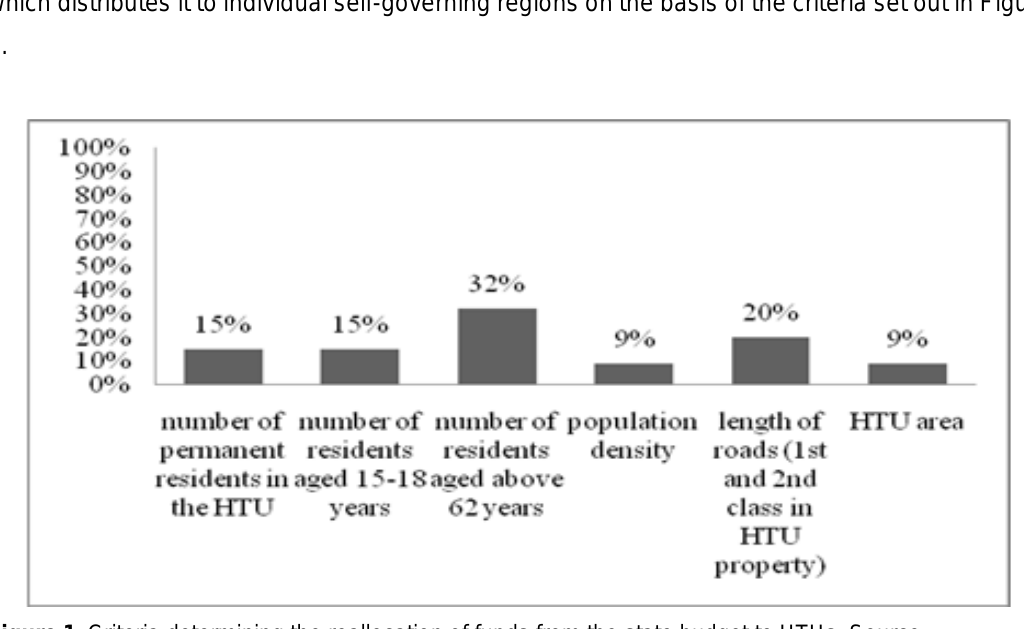
Figure 1 . Criteria determining the reallocation of funds from the state budget to HTUs. Source: Government Regulation no. 668/2004 Coll. About the distribution of revenue from the income tax of the territorial